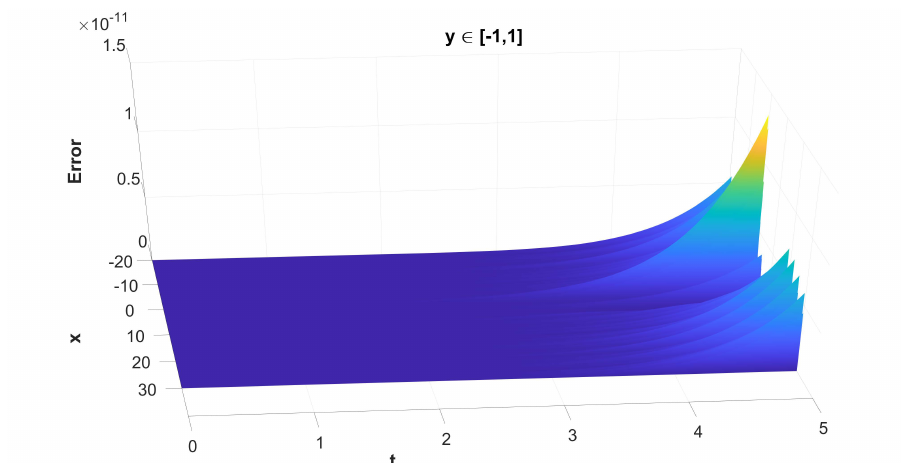
Figure 10. The maximum, along y , absolute error of the solution versus t and x without the use of finite difference schemes for the spatial semi-discretisation.